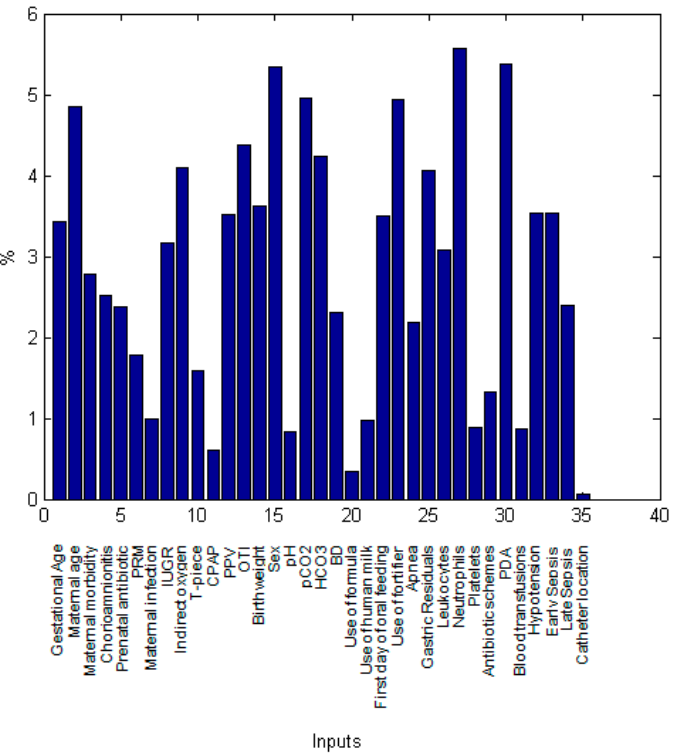
Figure 5. Relative contribution of each predictor variable to the estimation for the IP ANN model at birth and hospitalization. The relative influence histogram shows the mathematical importance of each predictor variable in the model evaluated by a sensitivity analysis. It is measured as a percentage of quantitative significance on the Y-axis for each predictor parameter at birth and during hospitalization.